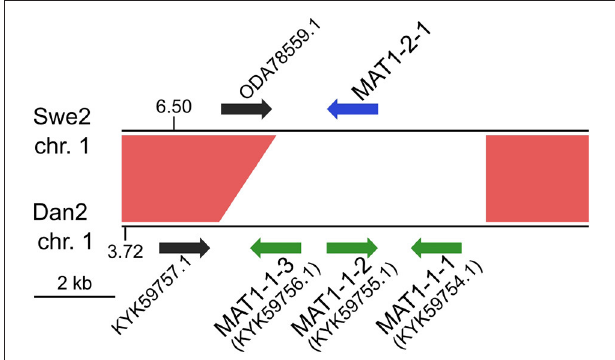
FIGURE 2 | MAT loci in D. coniospora . The Swe2 region syntenic to the Dan2 MAT locus is shown. The previously annotated Dan2 MAT genes are indicated with green arrows, labelled with their idiomorph identifiers. The newly identified Swe2 MAT1-2-1 gene is shown in blue. The red shapes highlight the extent of the sequence synteny, and the black arrows represent a pair of neighbouring orthologous